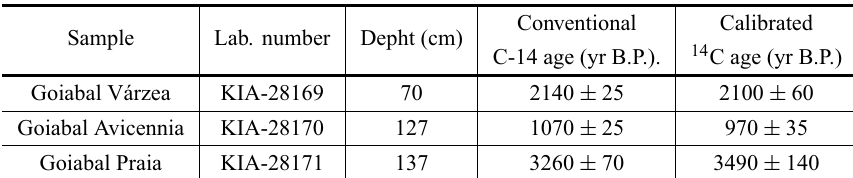
Radiocarbon dates (AMS) of the